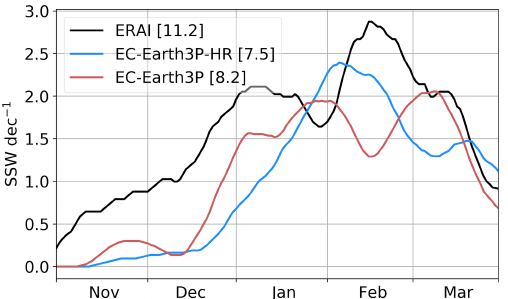
Figure 16. Seasonal distribution of SSWs per decade in a [ − 10, 10]d window around the SSW date for ERA-Interim (black), EC-Earth3P (red) and EC-Earth3P-HR (blue) from control-1950 . Time series are smoothed with an 11d running mean. The total decadal frequency of SSWs is indicated in